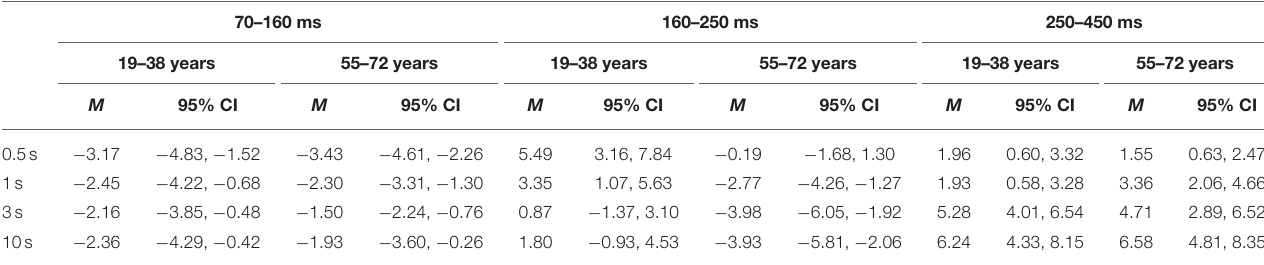
TABLE 3 | Summary of the mean amplitudes (in µ V) of the ERP difference waves (novel stimuli minus standard stimuli) at Fz separately for the two age groups, the four ISI conditions and the three time